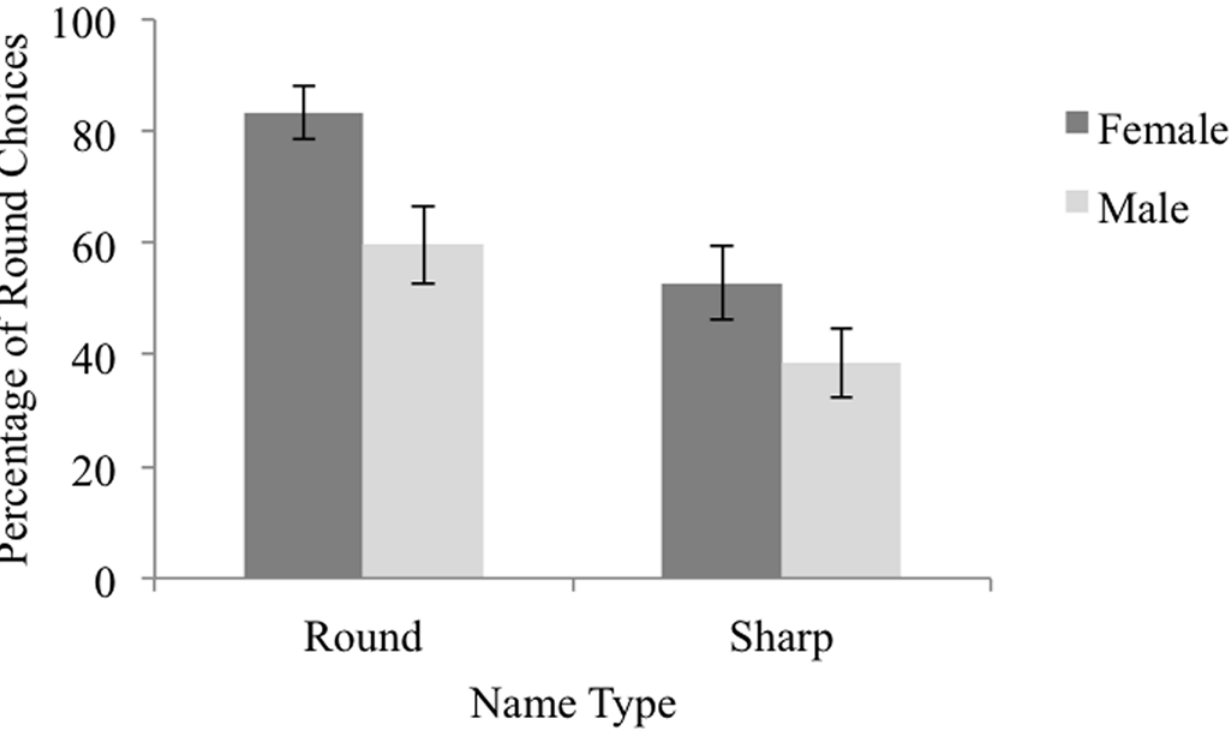
Fig 1. Percentage of Round Choices by Name Type and Gender in Experiment 1a. The percentage of trials on which participants selected the round silhouette as the best match for round-sounding and sharp-sounding, female and male names. Error bars reflect 95% confidence intervals computed using the method outlined by Cousineau [31] to remove between-subject variability.